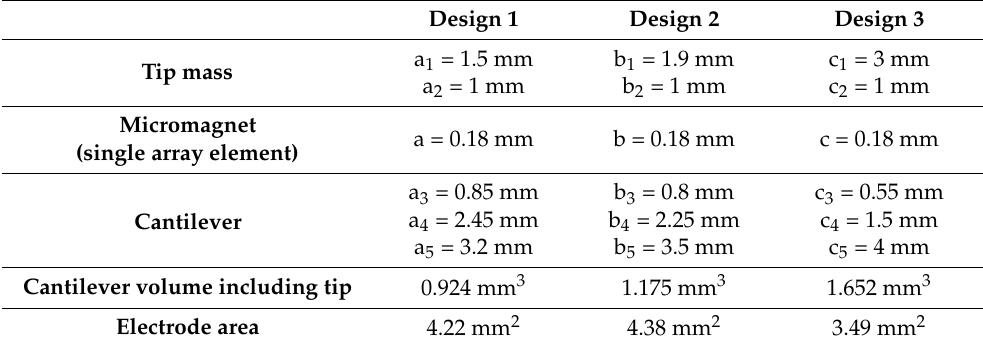
Table 3. Summary of the geometric parameters of the harvester designs.